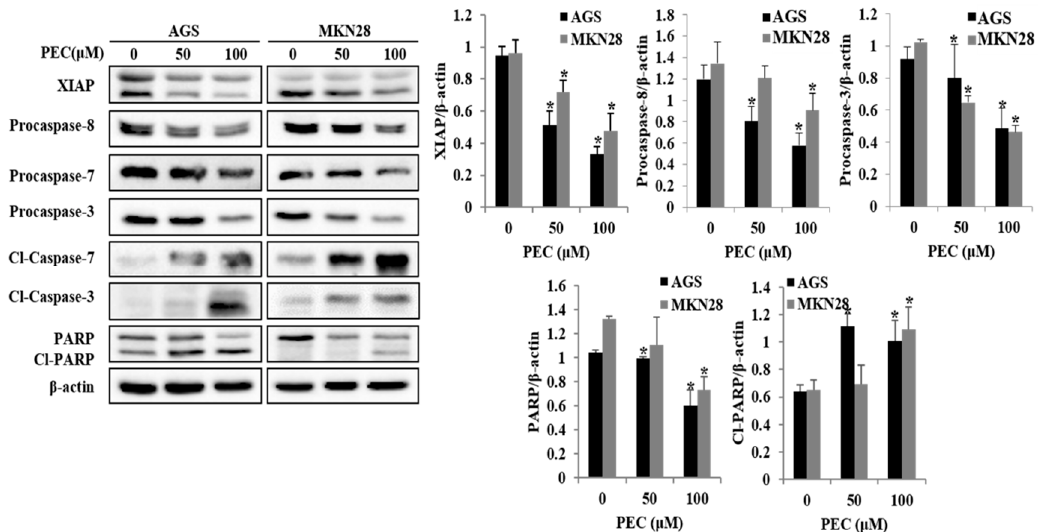
Figure 4. Effects of PEC concentration on the expression levels of XIAP, caspase-3/7 activation, and cleavage of PARP in AGS and MKN28 cells. AGS and MKN28 cells were treated with indicated concentrations of PEC for 24 h. The cell lysates were subjected to SDS-PAGE and analyzed by immune-blotting. Densitometry analyses of XIAP, Procaspase-8, Procaspase-7, Procaspase-3, cleaved caspase-7, cleaved caspase-3 and cleaved PARP proteins expressions are expressed as the mean ± standard deviation (SD) of at least three independent experiments. Statistical differences were analyzed with Student’s t -test (* p < 0.05 vs. control).